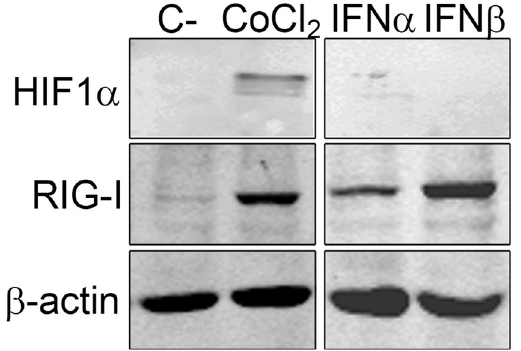
Figure 4. IFN- β stimulation of human myotubes induces RIG-I expression but not HIF-1 α stabilization. Human primary myotubes were stimulated with 100 U/ml of IFN- α or IFN- β , during 48 h. Lane1: Myotubes cultured in normoxic conditions; Lane 2: 250 μ M CoCl 2 -treated cultures; Lane 3 IFN- α treated cultures; Lane 4 IFN- β treated cultures. Lanes were run in the same gel but were noncontiguous. Three independent experiments were